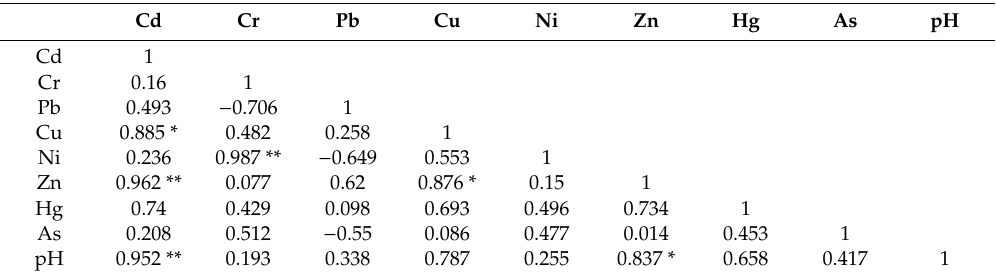
Table 4. Correlation coe ffi cients between heavy metals in tea garden